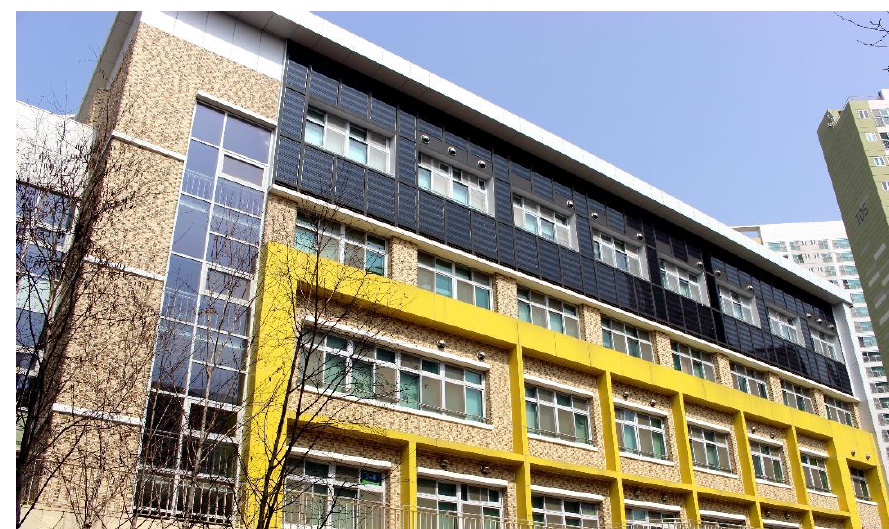
Figure 2. Demonstration building with air-type BIPVT collectors.